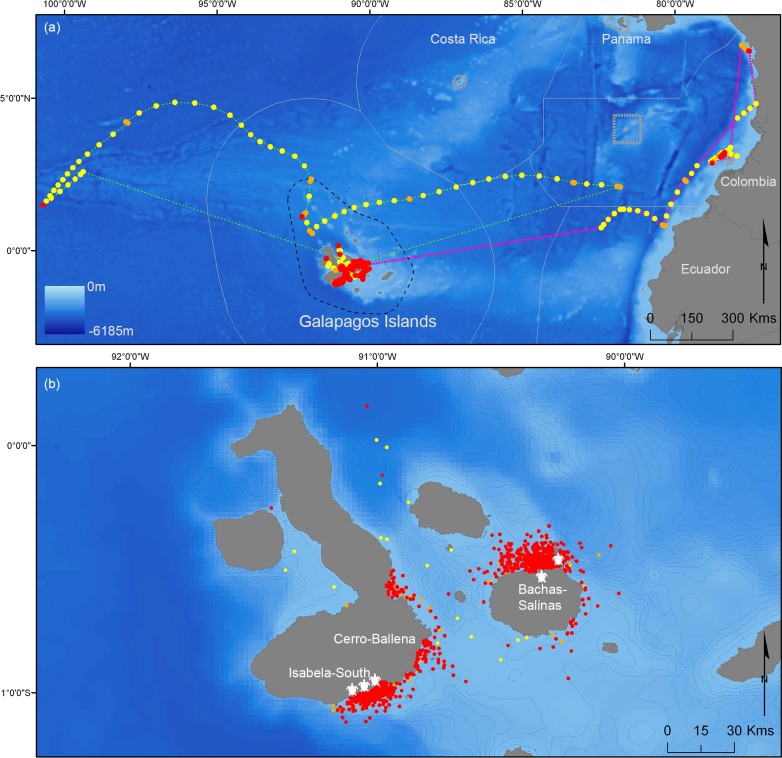
Patterns of residency behaviour of satellite tagged tiger sharks.Resident (red circles), transient (yellow circles) and undetermined (orange circles) behaviours associated with each 12-hour estimated position provided by the switching state-space model. Top panel (a) displays the complete tracks of TS2 and TS4 (pink and green dashed lines, respectively) overlaid with the exclusive economic zones (grey line) and marine protected areas (grey dashed line) of Eastern Tropical Pacific countries. Lower panel (b) shows the estimated positions of all tracked sharks within the Galapagos Marine Reserve (black dashed line, top panel), indicating the study sites, the most important turtle-nesting beaches (sea turtle icons) and the 100 m isobaths (blue dashed lines).